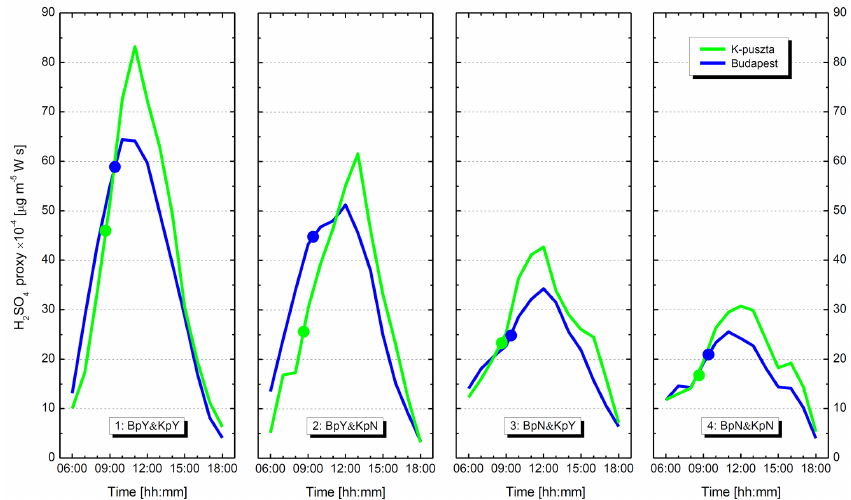
Figure 4. Hourly mean values of gas-phase H 2 SO 4 proxy in Budapest and at the K-puszta station averaged for the days when NPF events were identified in both Budapest and at the K-puszta station (BpY&KpY) and when there was an event in Budapest and no event at the K-puszta station (BpY&KpN), no event in Budapest and an event at the K-puszta station (BpN&KpY), and no event in both Budapest and at the K-puszta station (BpN&KpN). The proxy values at the mean starting time t 1 of the NPF are indicated by dots on the